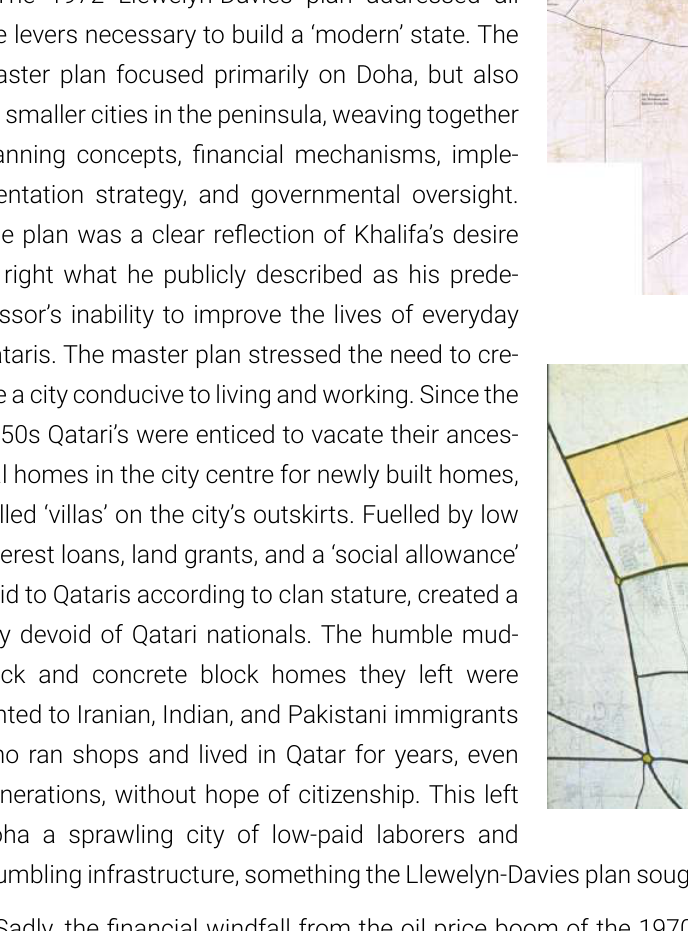
1972 Llewelyn-Davies master plan (Source: Llewelyn-Davies Architects)